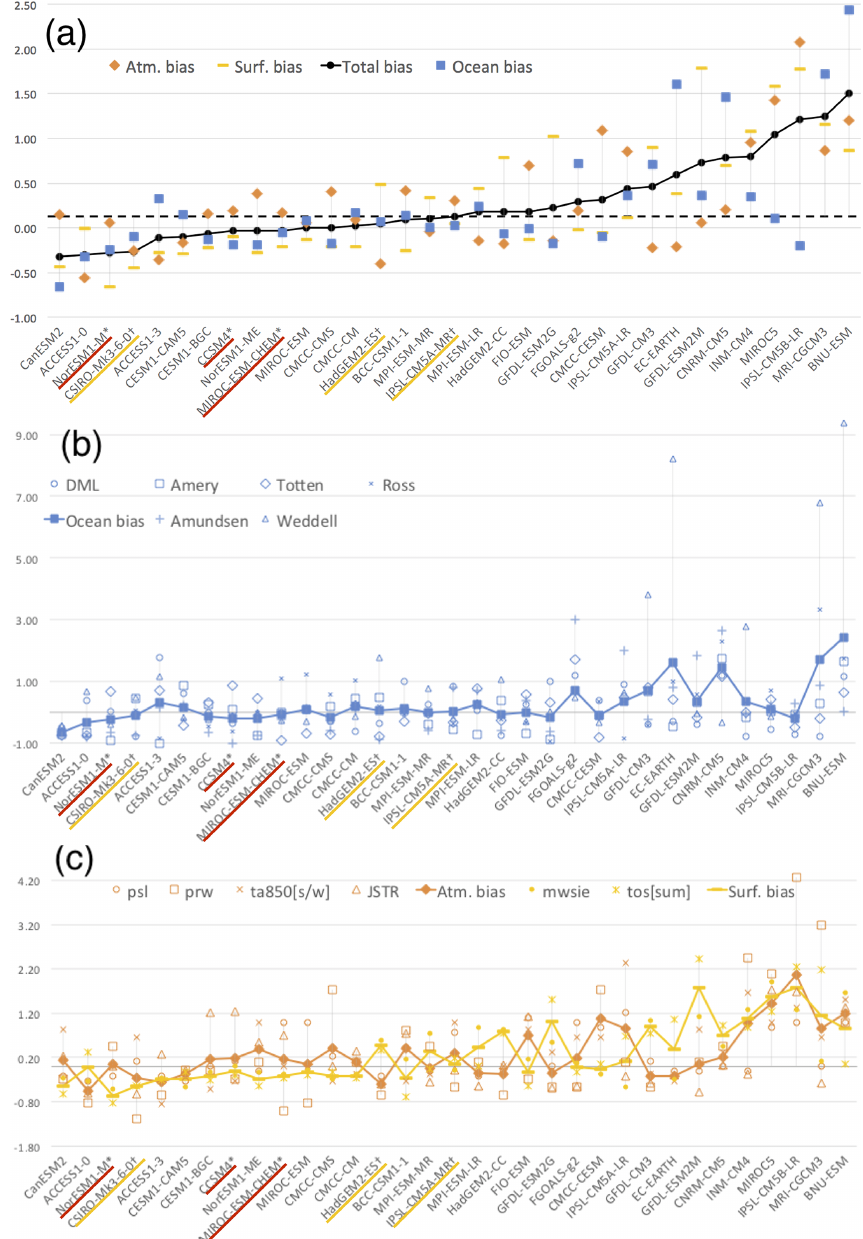
Figure 2. (a) Ranking of models according to total bias (black) over the Antarctic domain, with a breakdown of the ocean (blue), atmosphere (orange), and surface (yellow) contributions. (b) Breakdown of model performance in the ocean over the Antarctic domain. (c) Breakdown of model performance in the atmosphere (orange) and ocean surface (yellow) over the Antarctic domain. Models are ranked according to total bias. Models selected in the top three (core) ensemble are underlined in red with an asterisk, and models in the top six (targeted) ensemble are underlined in yellow with a †